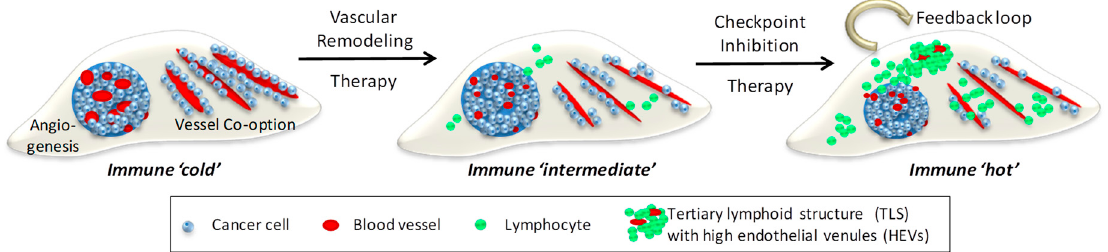
Figure 2. Combination Vascular-Immune Therapy in Metastatic Cancer. Left, depicted are 2 distinct metastatic vascularization patterns in host tissue, neo-angiogenesis and co-option of existing blood vessels. Developing tumors are devoid of lymphocytes and therefore immune ‘cold’. Middle, vascular remodeling therapy, e.g., anti-angiogenesis and anti-co-option strategies, normalize aberrant angiogenic vessels and reduce cancer adhesion to pre-existing vessels. Improved tumor perfusion facilitates lymphocyte influx and alleviates immune suppression, thus creating an immune ‘intermediate’ environment. Right, this sets the stage for checkpoint inhibitors to activate local adaptive immunity and generate a positive feedback loop where normalized vessels increase T cell infiltration and activated effector T cells normalize blood vessels for more lymphocyte influx. A critical mass of T and B cells forms clusters resembling tertiary lymphoid structures (TLS) containing high endothelial venules (HEVs) which further support naive and memory T cell migration. A self-perpetuating immune ‘hot’ environment has been created following sequential vascular remodeling and immune enhancing combination